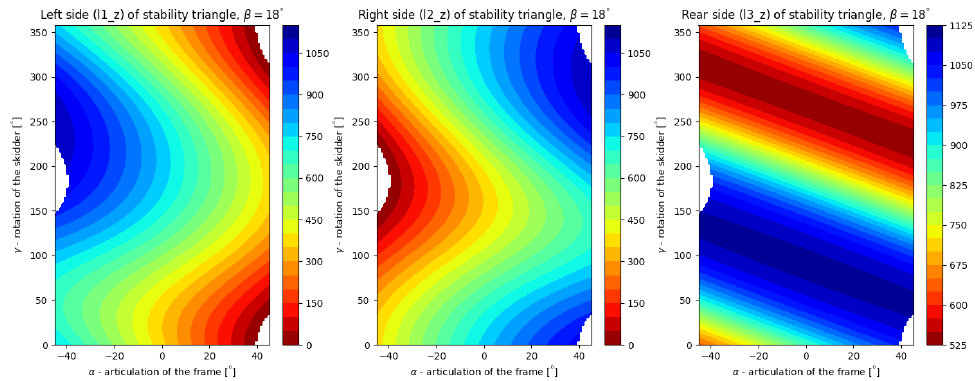
Figure 8. Firefighting device stability for half-filled water tank (1000 L) behind rear axle (C3